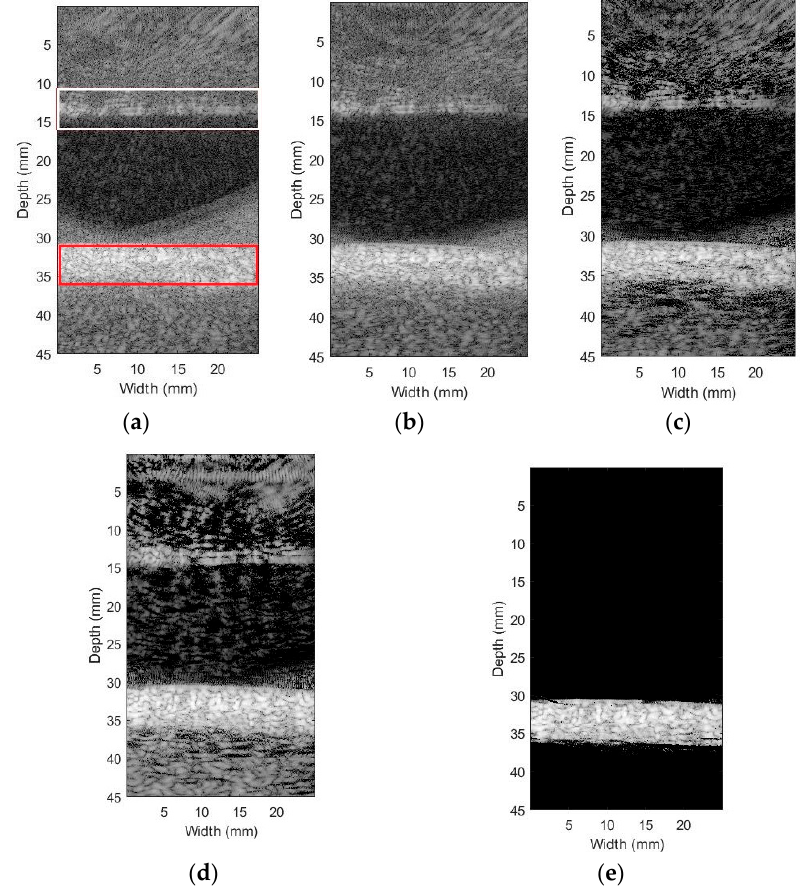
Figure 8. The image results of phantom experiment (with pork): ( a ) DAS; ( b ) MV; ( c ) ESBMV; ( d ) BWT; ( e ) bubble region detection.